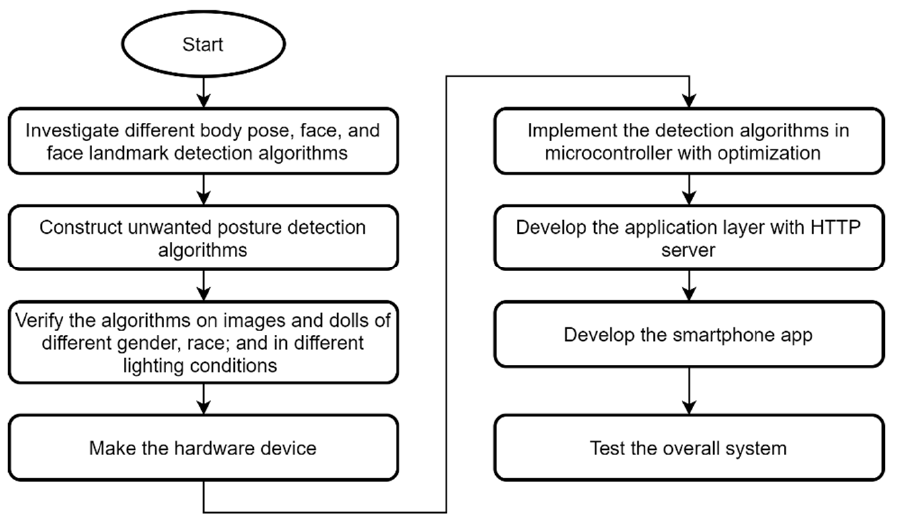
Figure 2. Flowchart showing the steps for developing the detection algorithms and the prototype.